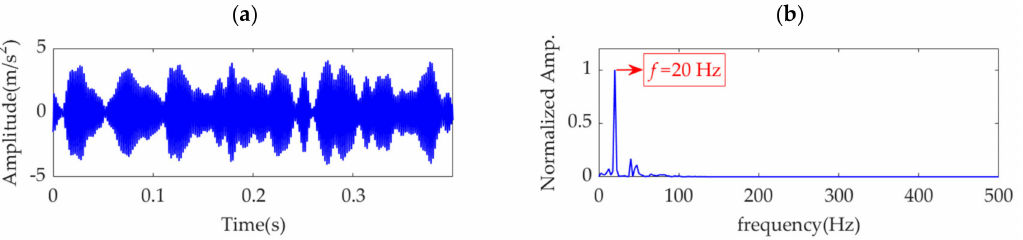
Figure 7. Desired mode obtained by VME with α = 9000: ( a ) time–domain waveform and ( b ) SES.